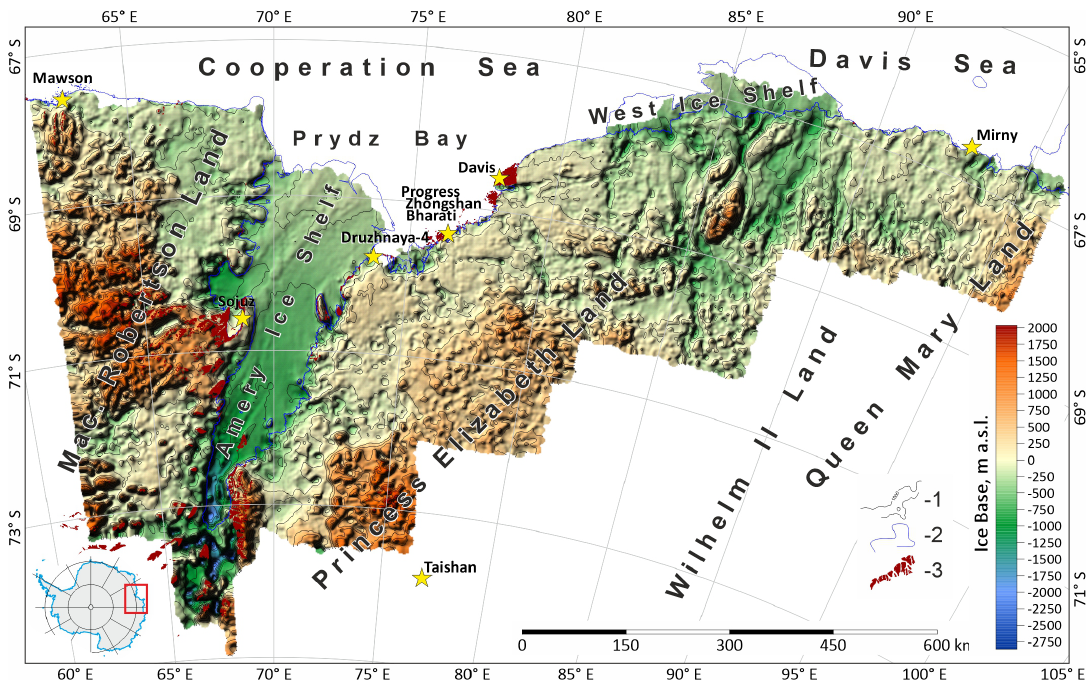
Figure 8. Ice base of the research area. 1—Ice base contours in meters; contour interval is 250 m; 2—ice front and grounding line from [20]; 3—outcrops from